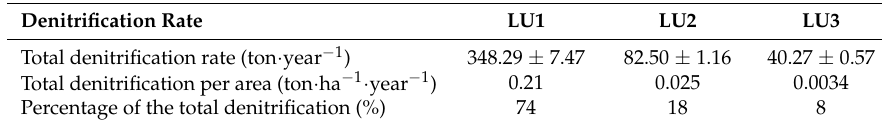
Table 6. Annual denitrification rates in the